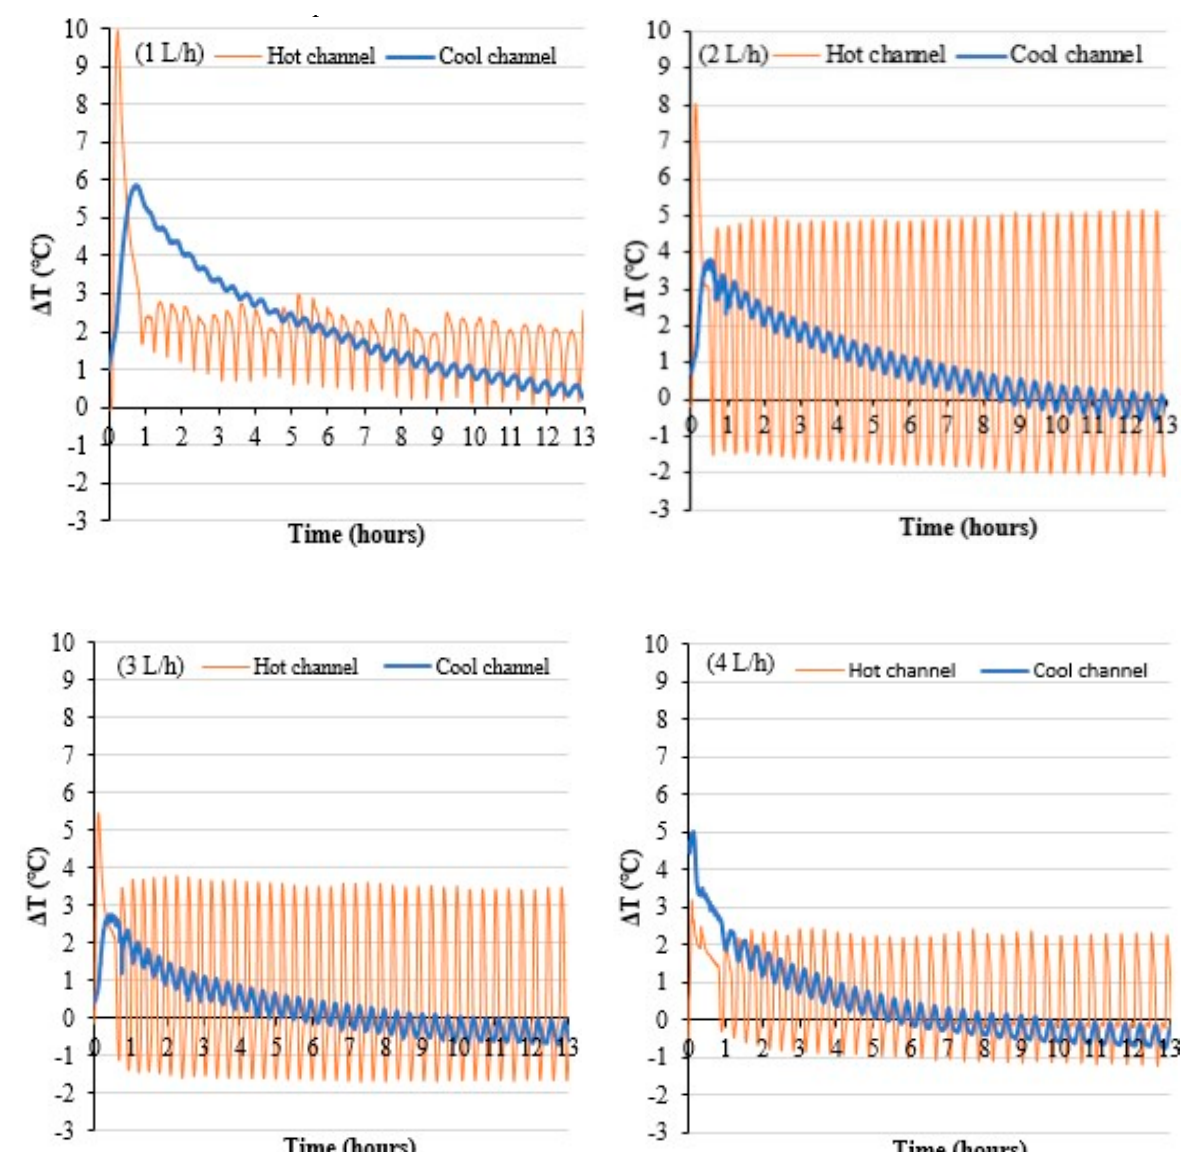
Figure 16. Evolution of channel temperature differences in controlled mode.